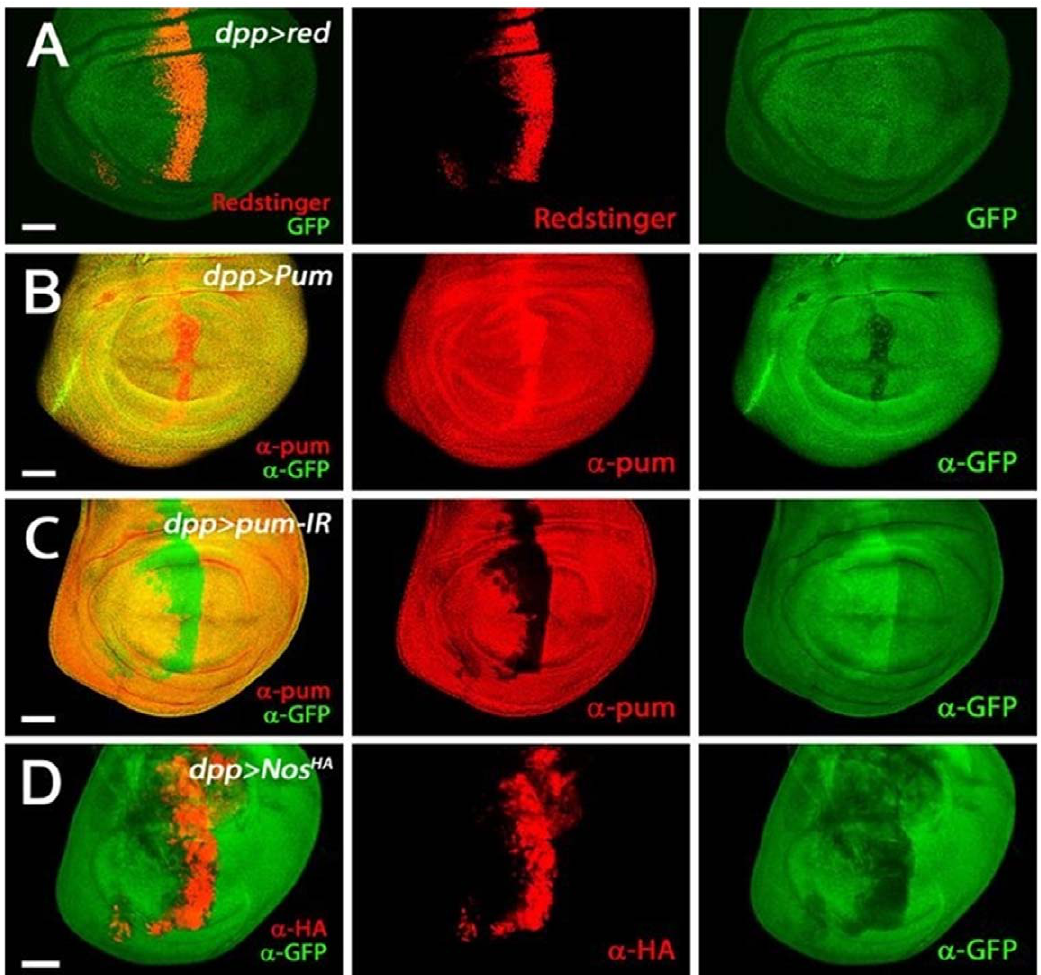
Figure 4. Pum activity in the wing disc. The 3 rd larval wing discs harboring a tub-GFP-NRE construct were visualized by GFP or redstinger fluorescence or immuno-stained by antibodies ( a -GFP, a -Pum and a -HA). The dpp-Gal4 driven expression of redstinger (A), Pum (B), Pum-IR (C), and Nos (D) were monitored, as shown in the second column. Pum activity level was monitored by GFP signals, as shown in the third column. The first column is the merged images of the second and third columns. Scale bars indicate 50 m